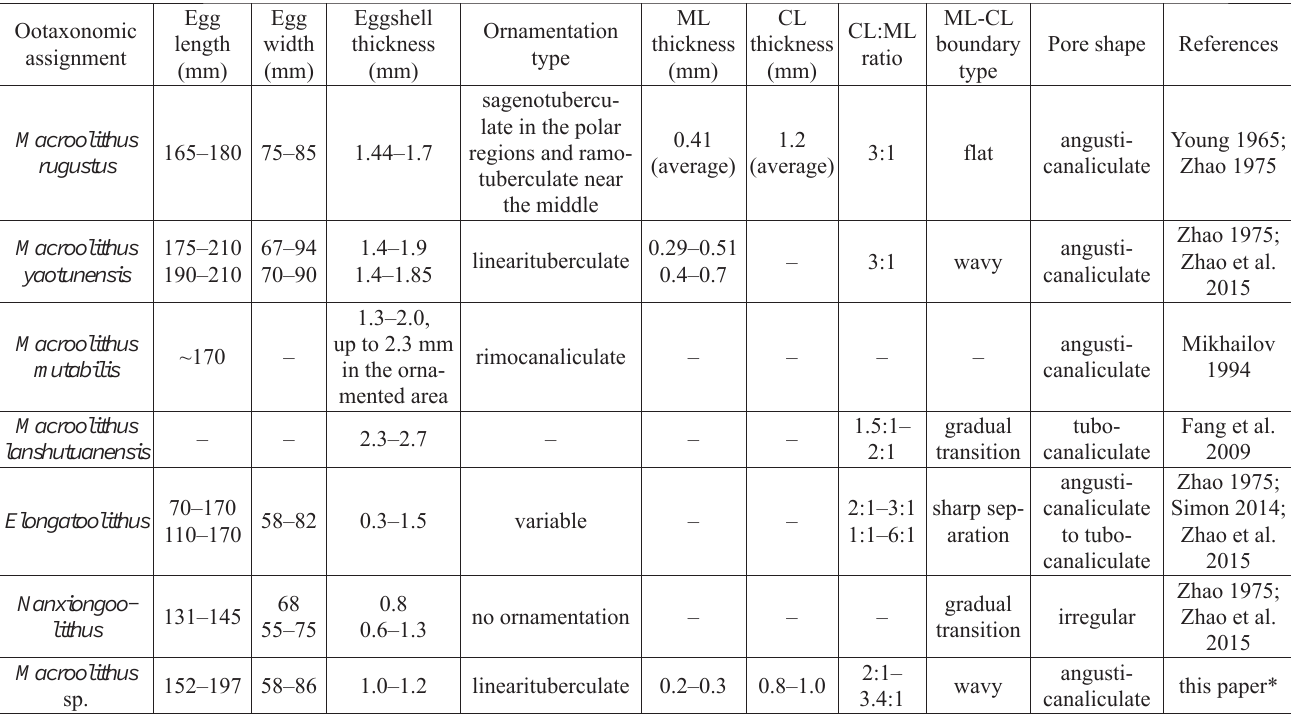
Table 3. An overview of the egg gross morphology and microstructural features of elongatoolithid eggs for ootaxonomic identification of the studied clutches; * specimens in this paper include HGM-41H-V0074, DM-2014-P0154, PFMM-0014002972, PFMM-0014004392, and PFMM- 0014003019. Abbreviations: CL, continuous layer; ML, mammillary